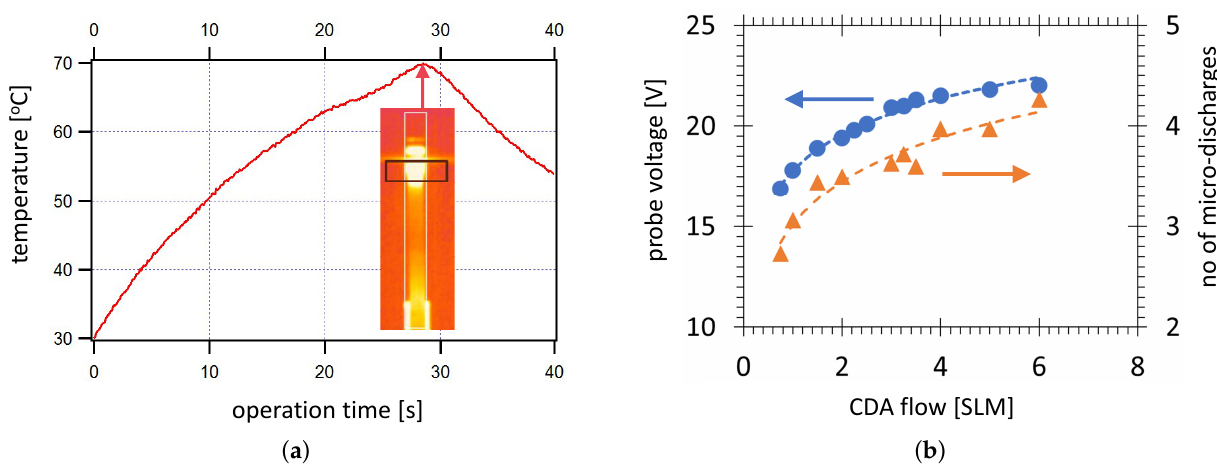
Figure 5. Thermal characterization of the PCPG. ( a ) the IR camera picture of the CeraPlas™F with temperature trace collected at position depicted by rectangle; ( b ) influence of the CDA flow on the voltage and the number of micro-discharges per the oscillation cycle of